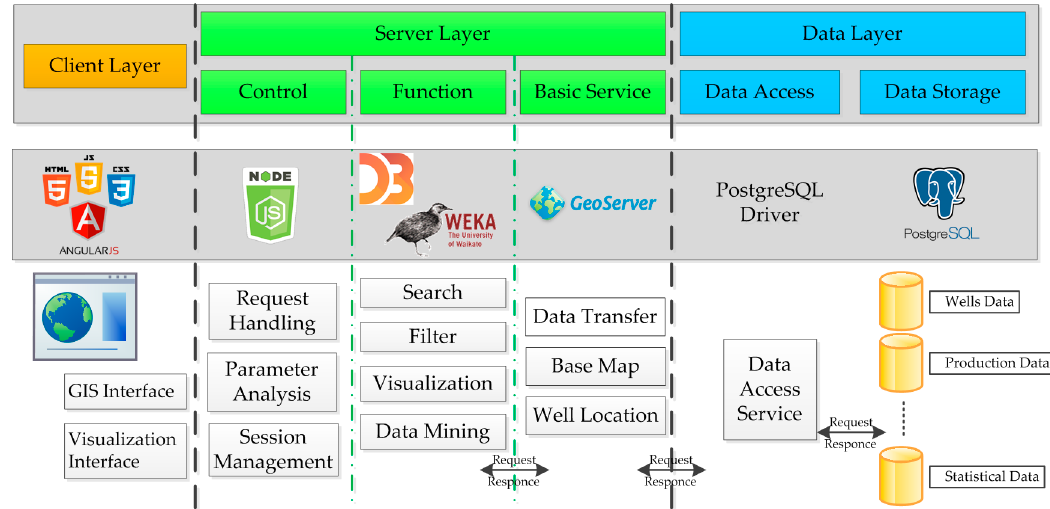
Figure 1. System Architecture of Oil and Gas Visual Exploration System.